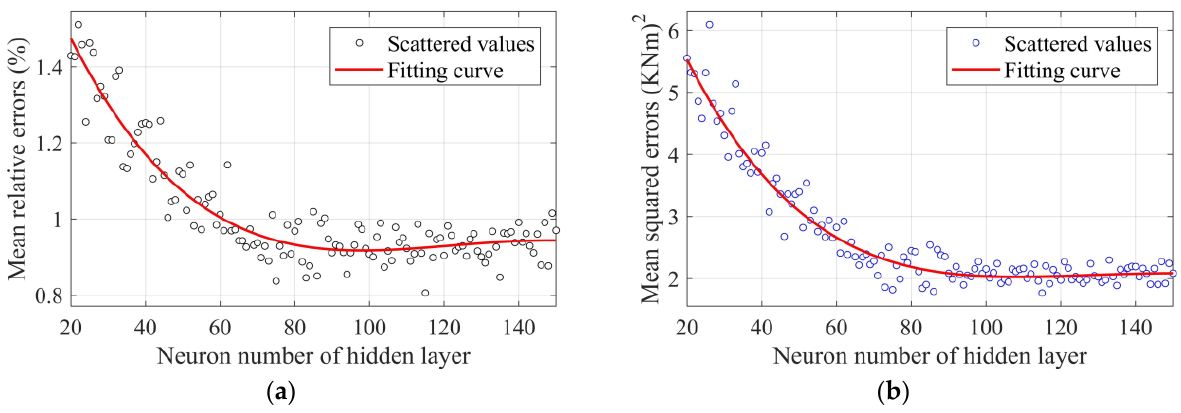
Figure 10. Wing bending moment prediction accuracy against different neuron number 𝐾 of hidden layer: ( a ) mean relative errors and ( b ) mean squared errors.